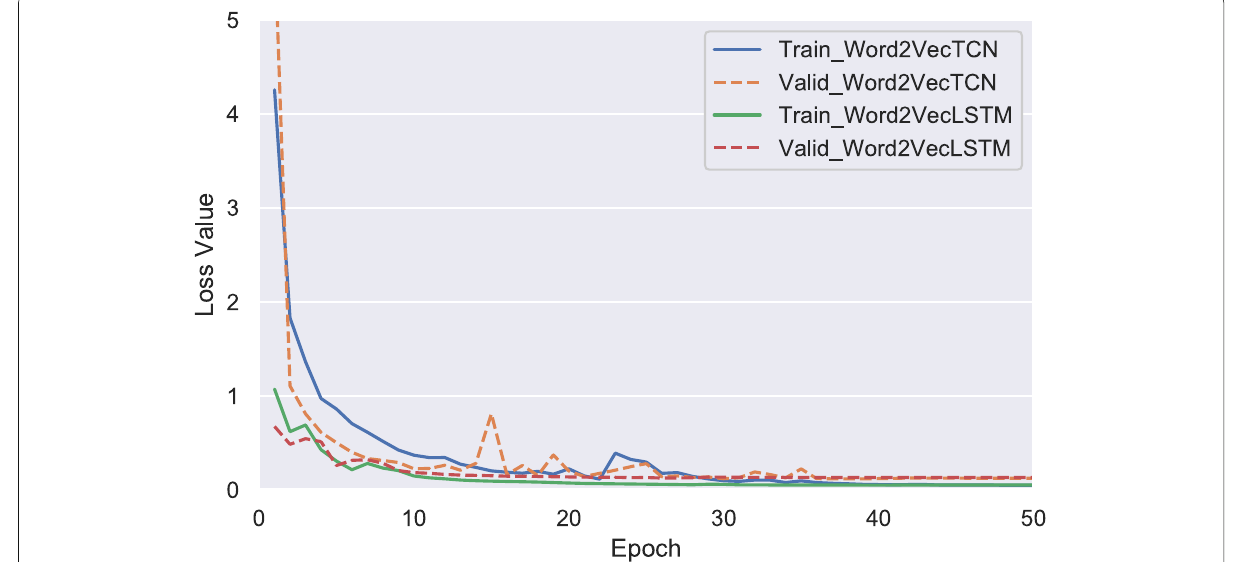
Fig. 11 The loss comparison between the state-of-the-art approach and our proposed scheme